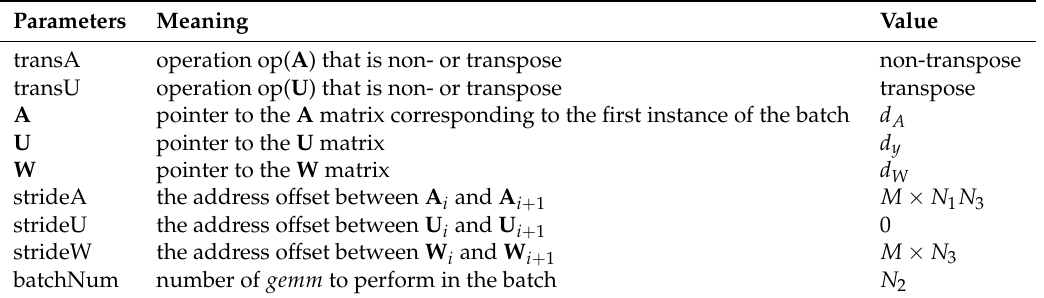
Figure 3. Multiplication of block diagonal matrices on GPU. Table 1. The parameters of the gemmStridedBatchd() routine in the cuBLAS